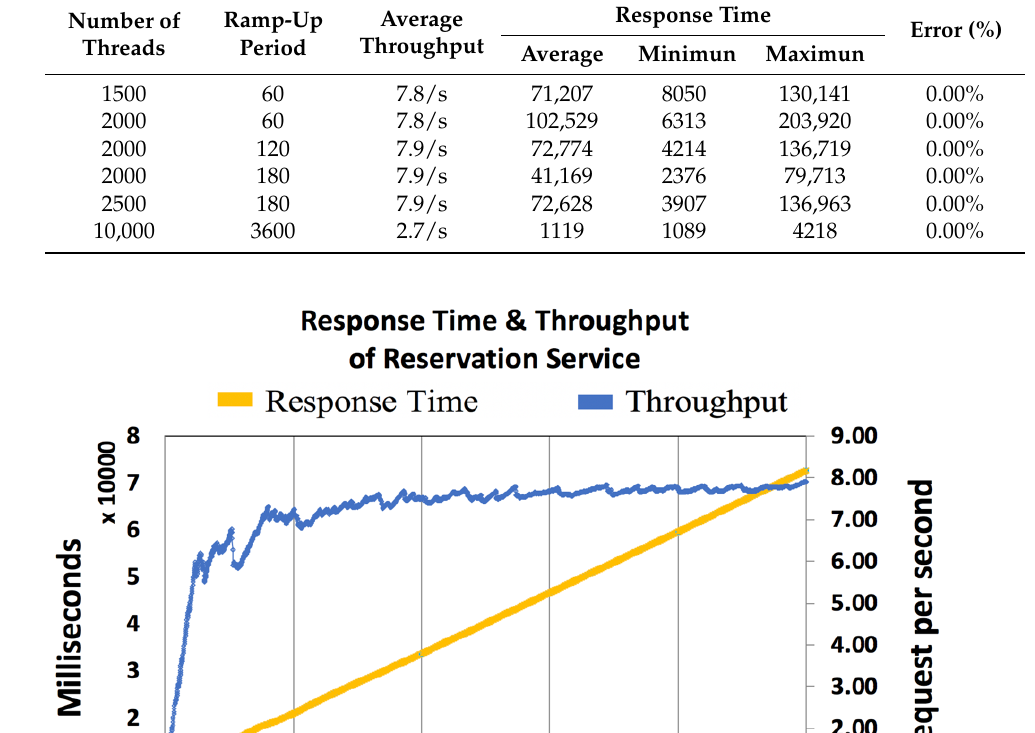
Table 16. Apache JMeter metrics of the reservation service.